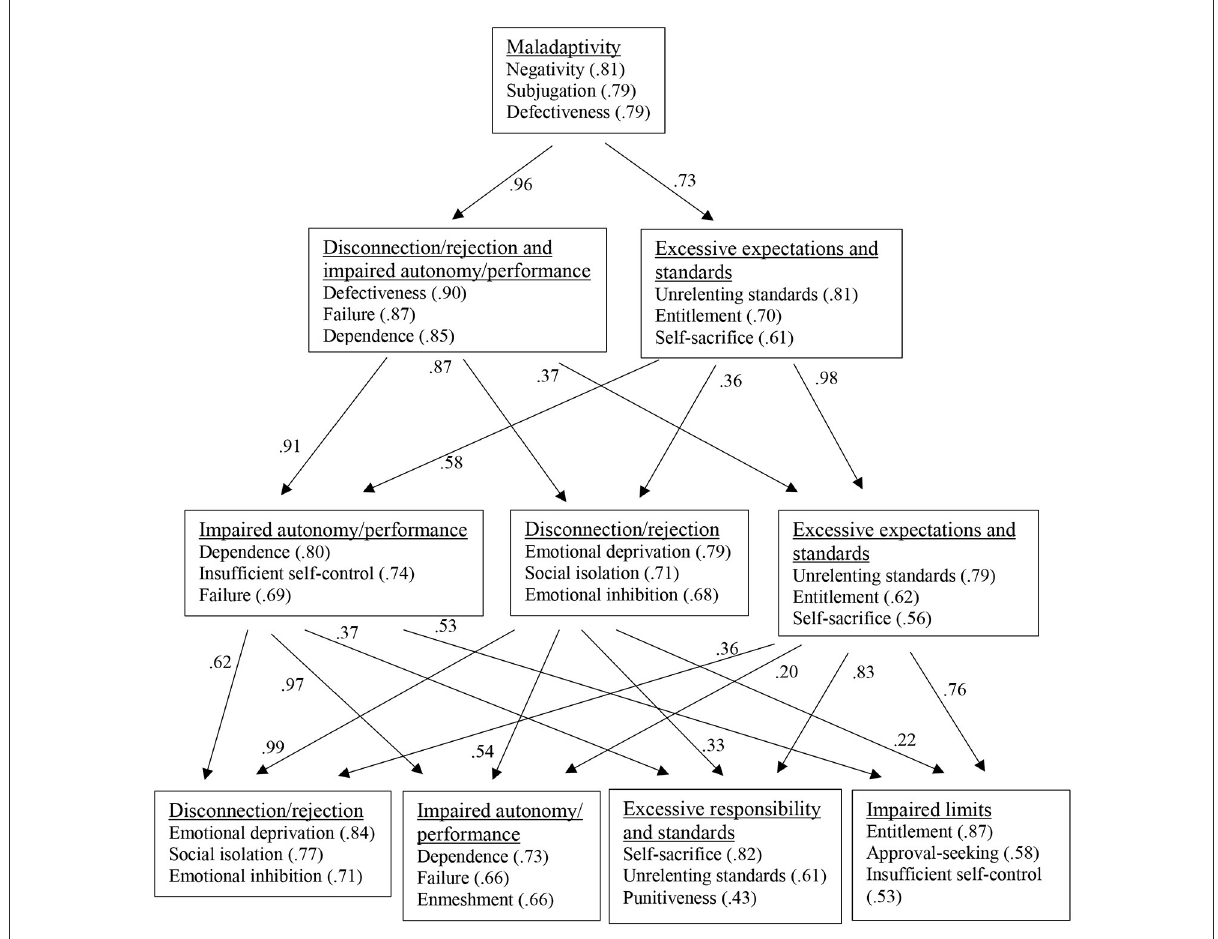
FIGURE2 Results of the bass-ackward